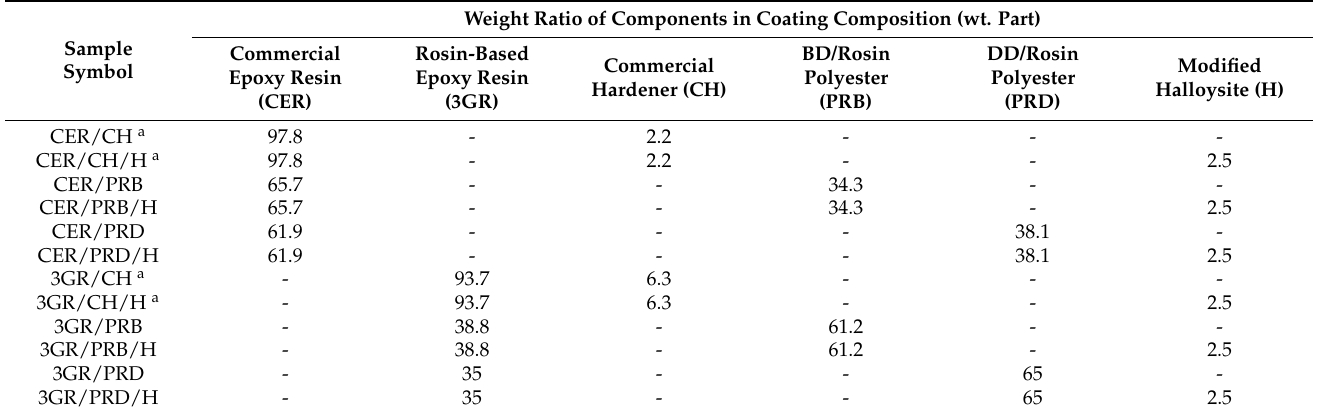
Table 2. Symbols and composition of prepared coatings and reference samples.